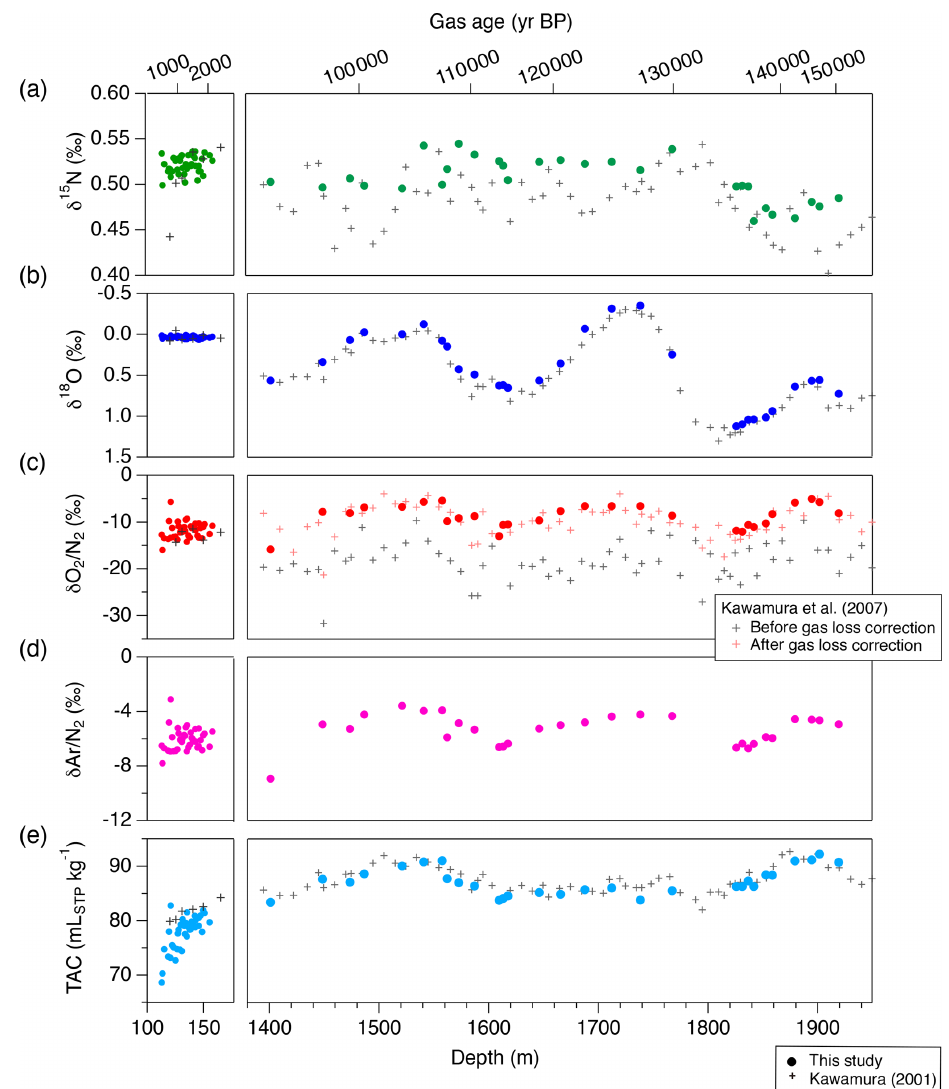
Figure 16. The DF records of mass spectrometer measurements and TAC from this study (filled markers), and comparison with previ- ous records from the same core on the DFO-2006 gas age scale (crosses, Kawamura, 2000; Kawamura et al., 2007). (a) δ 15 N, (b) δ 18 O, (c) δ O 2 / N 2 , (d) δ Ar / N 2 and (e) TAC. For the previous δ O 2 / N 2 records in the right subpanel of panel (c) , both raw data (black) and corrected data for gas-loss fractionation during core storage at − 25 ◦ C (red) are